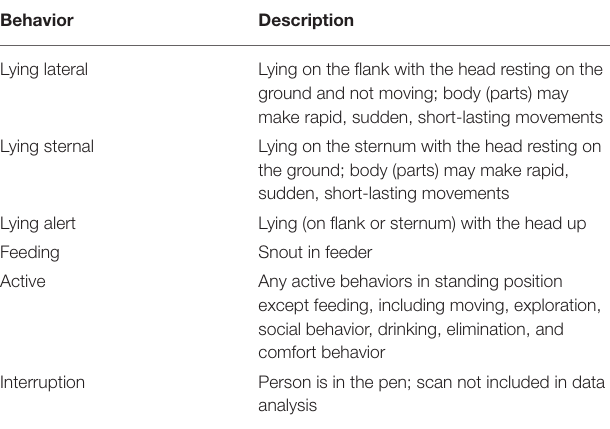
TABLE 2 | Ethogram for behavioral signs of